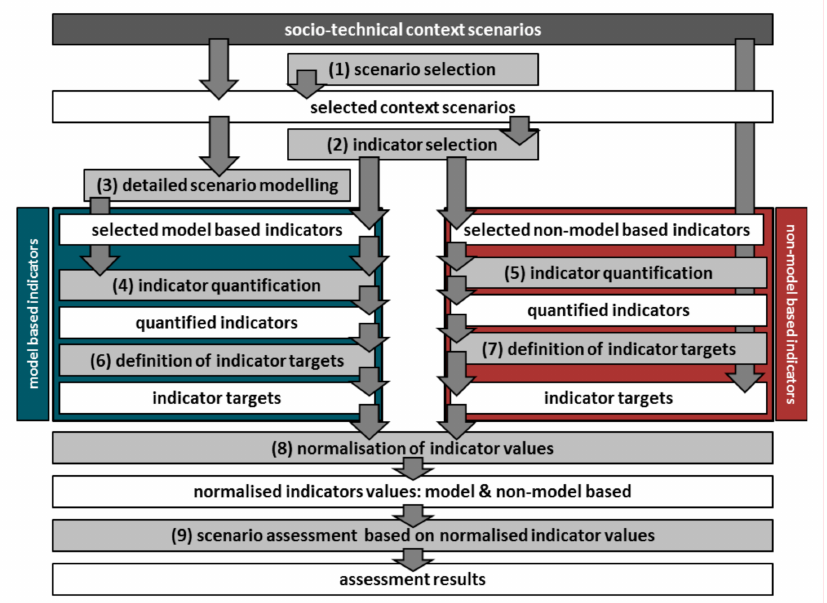
Figure 1. Overview of the workflow, the different working steps (grey background), and the results from each working step (white background) in this